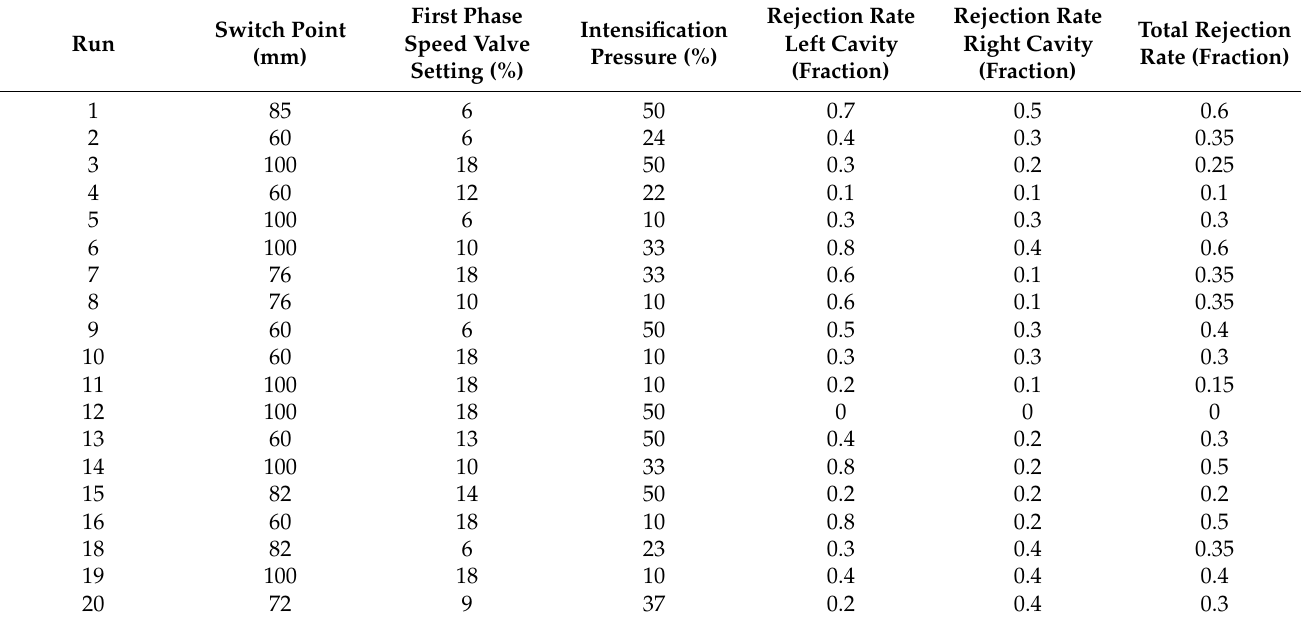
Table 2. Experimental plan and